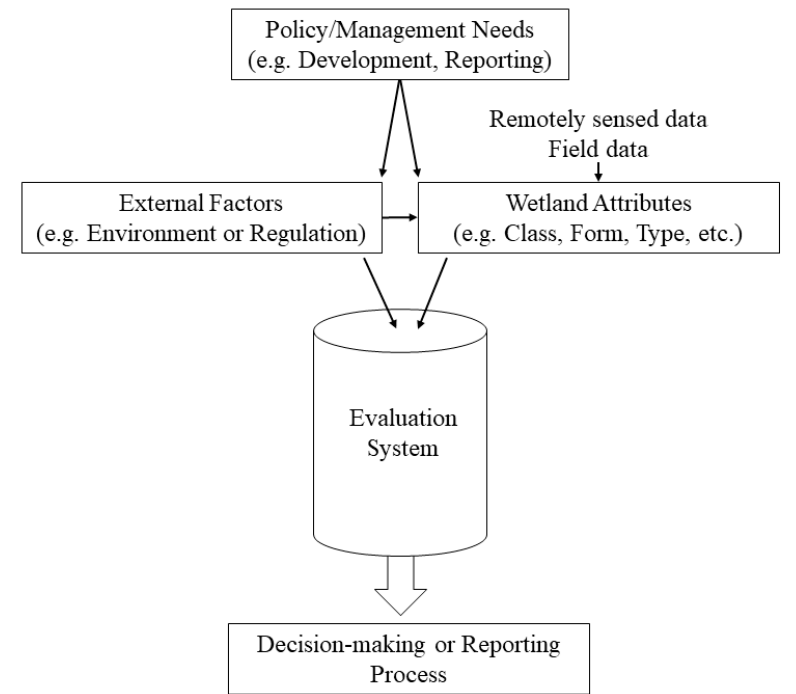
Figure 1. Linking policy and management needs for wetlands through an evaluation system used at the local to federal level for decision-making and reporting by facilitating more accurate measures and interactions of landscape level external drivers and wetland attributes.